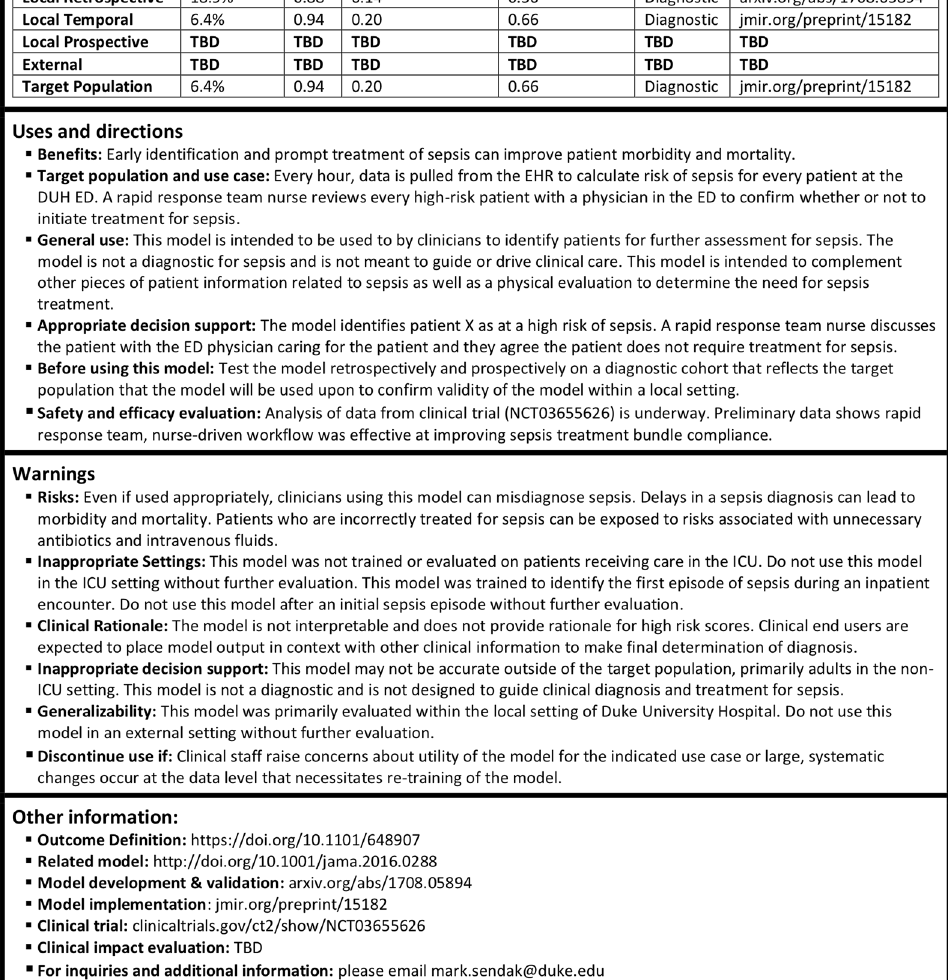
Fig. 1 Example “ Model Facts ” label for a sepsis machine learning model. This “ Model Facts ” label provides relevant information about a sepsis prediction model to clinical end users who use the model to assist with clinical diagnosis of sepsis. AUC Area Under the ROC Curve, PPV Positive Predictive Value, DOI Digital Object Identi fi er, EHR Electronic Health Record, ED Emergency